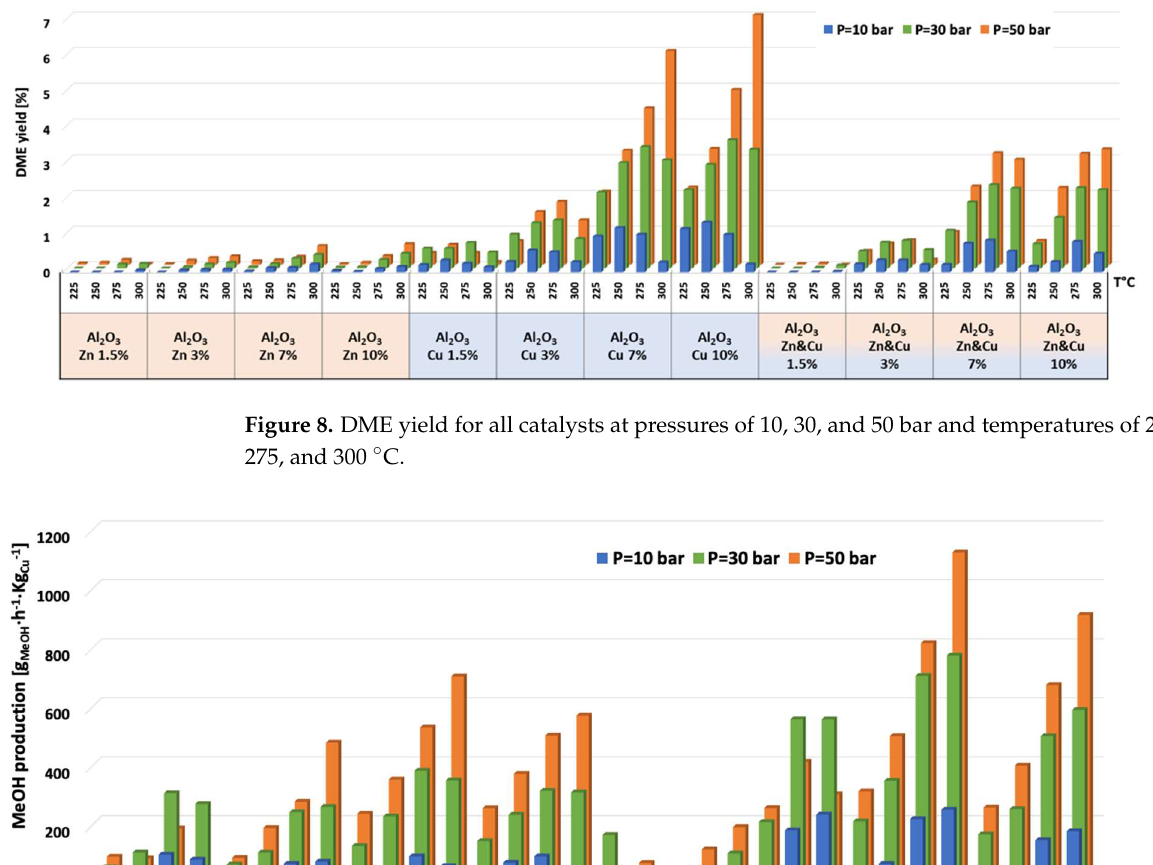
Figure 9. Production of methanol per gram of Cu for AlNFs-Cu and AlNFs-1Cu2.3Zn catalysts at pressures of 10, 30, and 50 bar and temperatures of 225, 250, 275, and 300 °C.